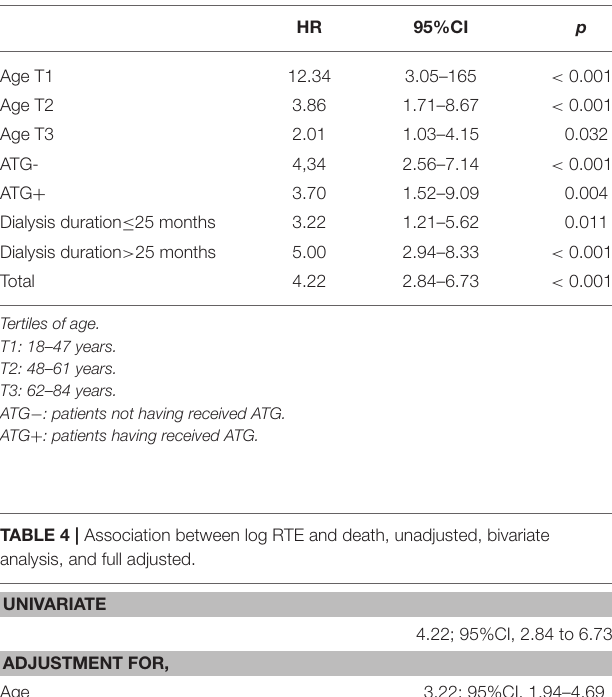
TABLE 3 | Association between log RTE and death in different sub-populations.